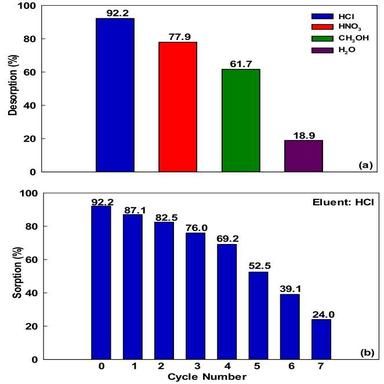
Influence of different eluents on OTC desorption efficiencies (a) and regeneration cycles on OTC sorption efficiencies onto MnFe2O4@BAC (b).